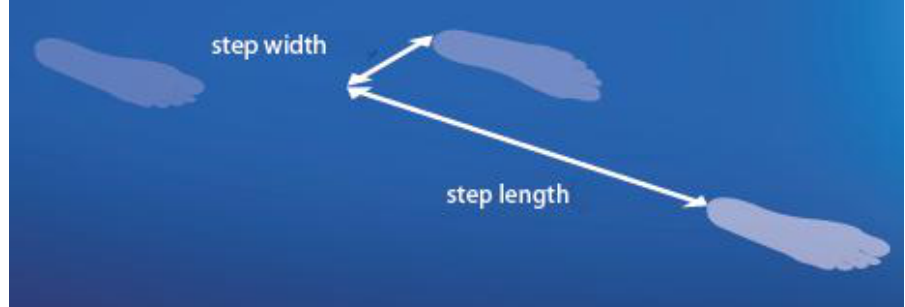
Figure 5. Spatio-temporal gait parameters, step length, and step width.